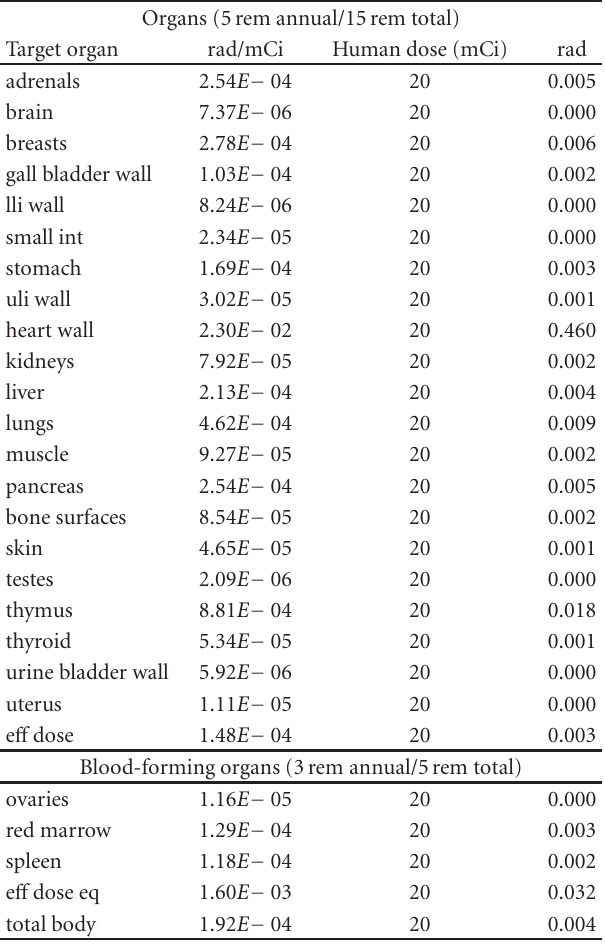
Table 3: Radiation dose estimates of reference adult for 68 Ga-GP from